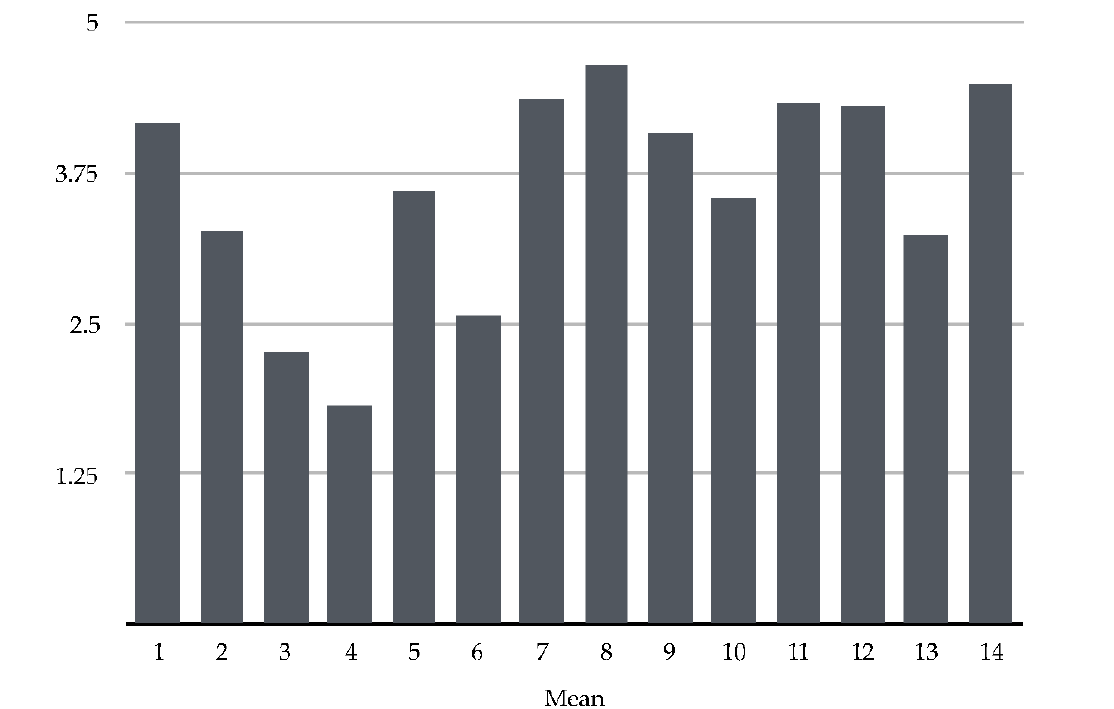
Figure 1. Environmental domestic routine behavior results in average